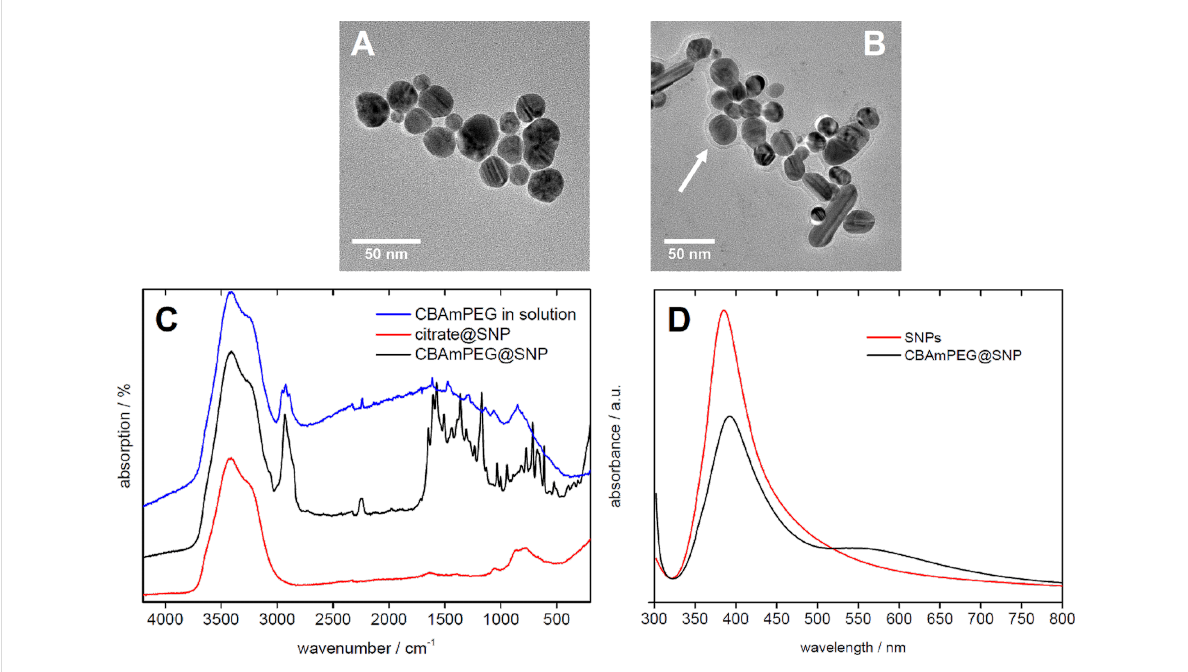
Figure 2: TEM images of A) citrate@SNPs and B) CBAmPEG@SNPs. C) Raman spectra of aqueous solutions or suspensions of CBAmPEG, CBAmPEG@SNPs, and citrate@SNPs. A detailed assignment of the Raman bands is given in the Experimental section. D) UV–vis spectra of SNP without polymer modification and